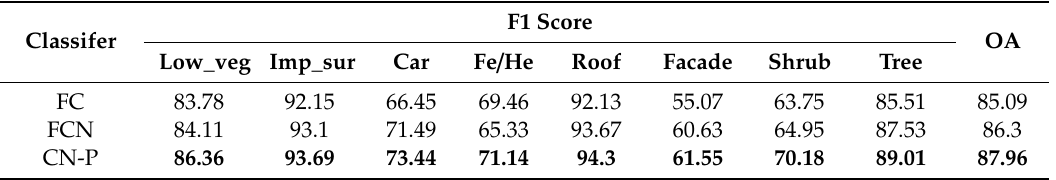
Table 1. F1 score of each class and overall accuracy (OA) using di ff erent classification network on ISPRS benchmark dataset. Bold numbers show the highest values (%).